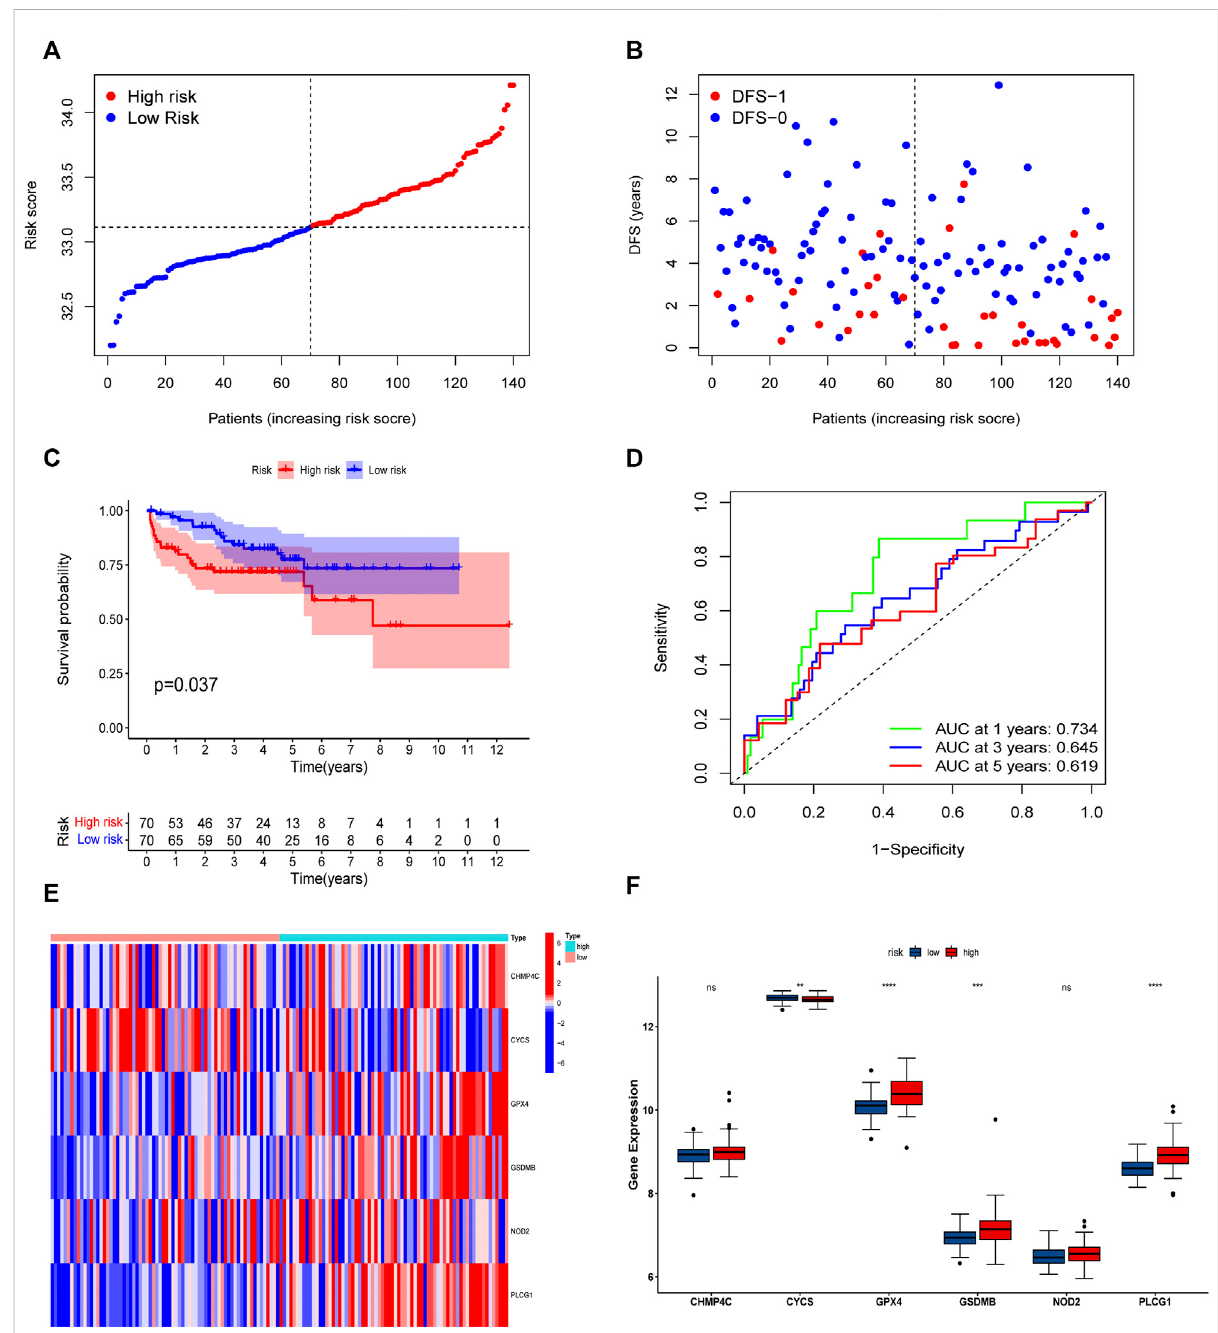
FIGURE 6 Risk model based on the 6 hub genes in MSKCC cohort. (A) Distribution of patients ’ risk scores. (B) Distribution of survival status of patients in high and low risk groups. (C) The KM curves in high and low risk groups of patients. (D) 1, 3, 5-year ROC curves. (E,F) The heatmap and bar graph of expression of 6 key genes in high and low risk